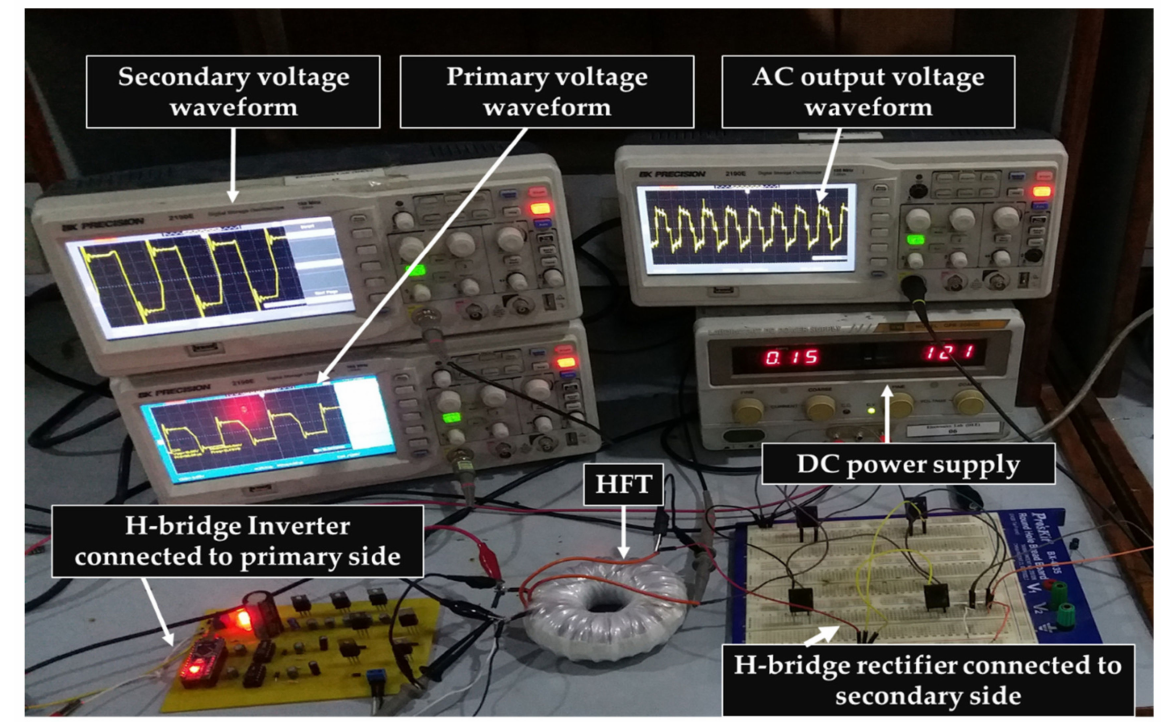
Figure 21. Toroidal transformer tested in a dual active bridge converter.